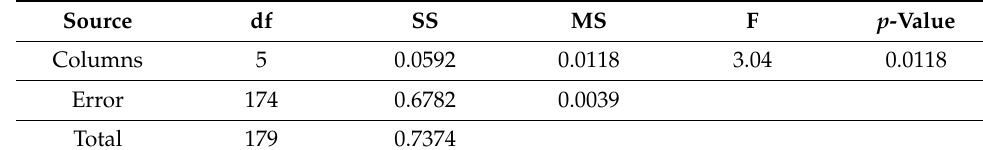
Table 9. ANOVA results for the second shadow scenario.